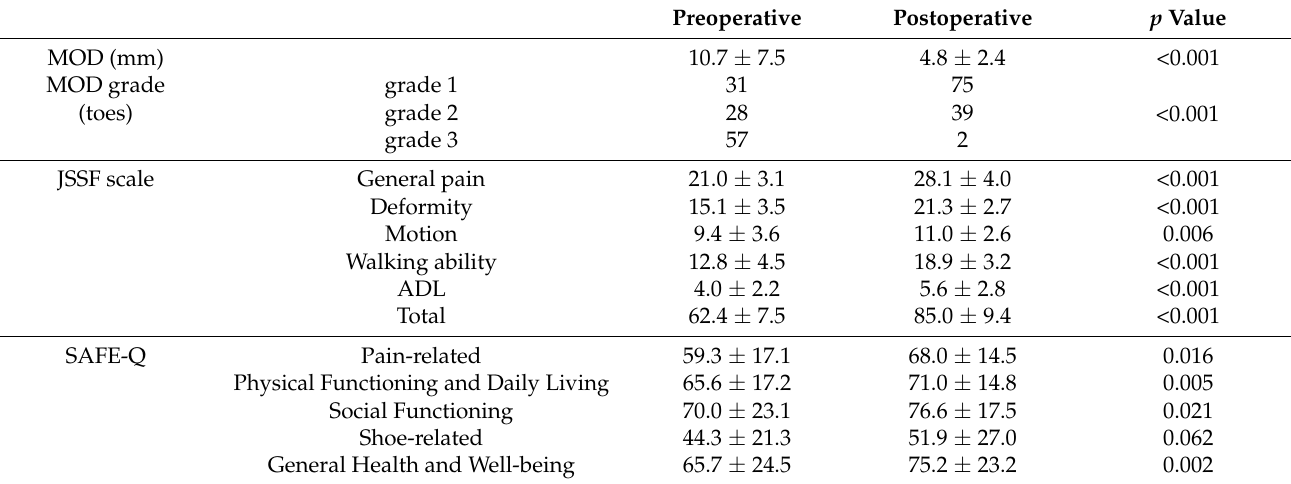
Table 2. Pre- and post-operative MODs, MOD grades, and clinical parameters.